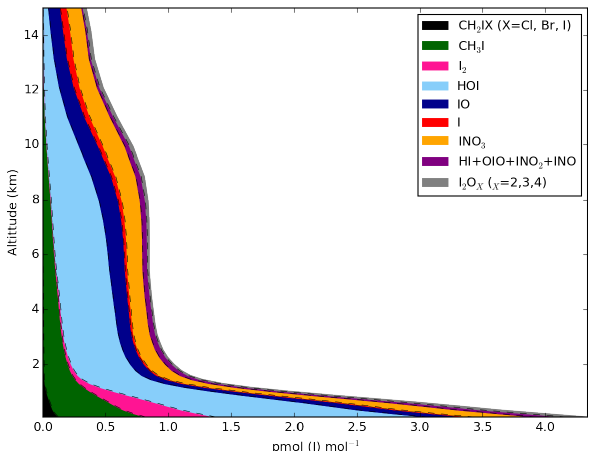
Figure 7. Schematic representation of implemented iodine chem- istry in the simulation with both iodine and bromine chemistry (“Br + I”). Average global annual mean burdens (GgI) are shown below key I Y species, with fluxes (TgIyr − 1 ) shown on arrows. Red lines, photolysis; blue lines, chemical pathways; green lines, emis- sion source; orange lines, heterogeneous pathway; purple lines, de- positional pathway. This equates to a total iodine source and sink of 3.8TgIyr − 1 . O 3 deposition in Tg is also shown to illustrate the driving force behind the inorganic emissions.